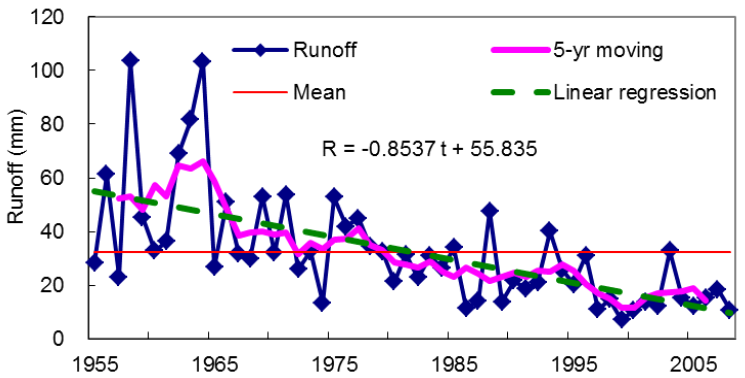
Figure 3. Variations in annual runoff and its five-year moving average process at the Daning station for 1955–2008.